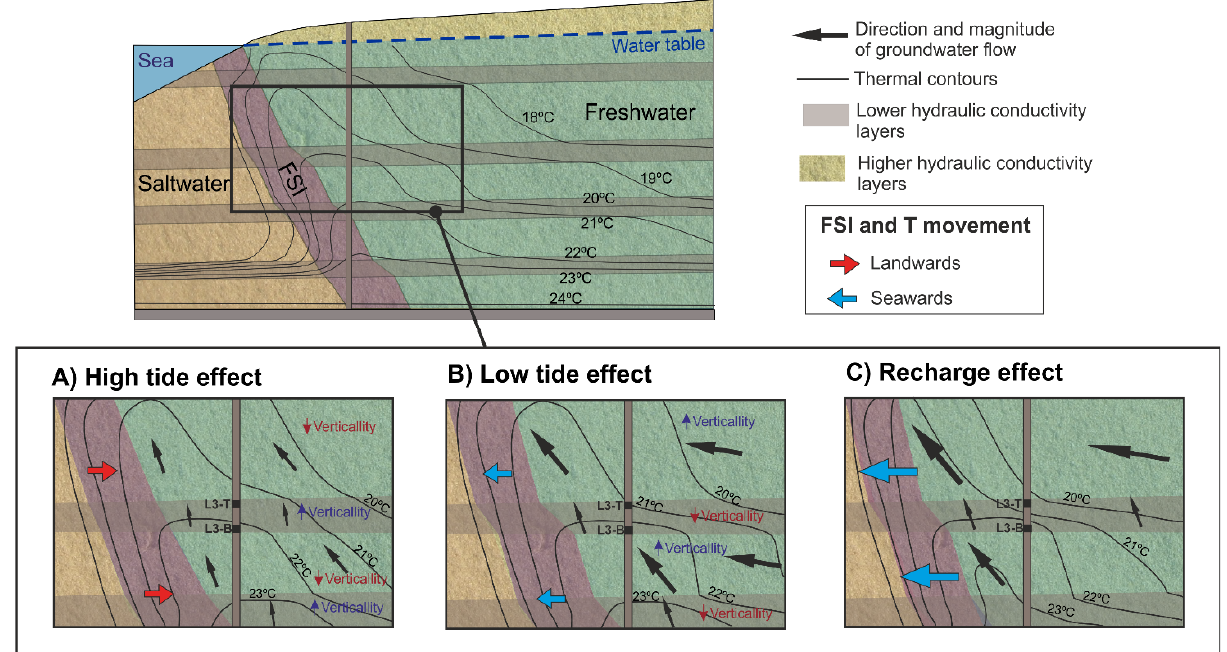
Figure 15. Representation of the effect of sea tides ( A , B ) and the increase of recharge ( C ) on the FSI and groundwater temperature distribution obtained from models B and C. The movement and verticality of the thermal contours and the FSI were exaggerated to improve the visualization.